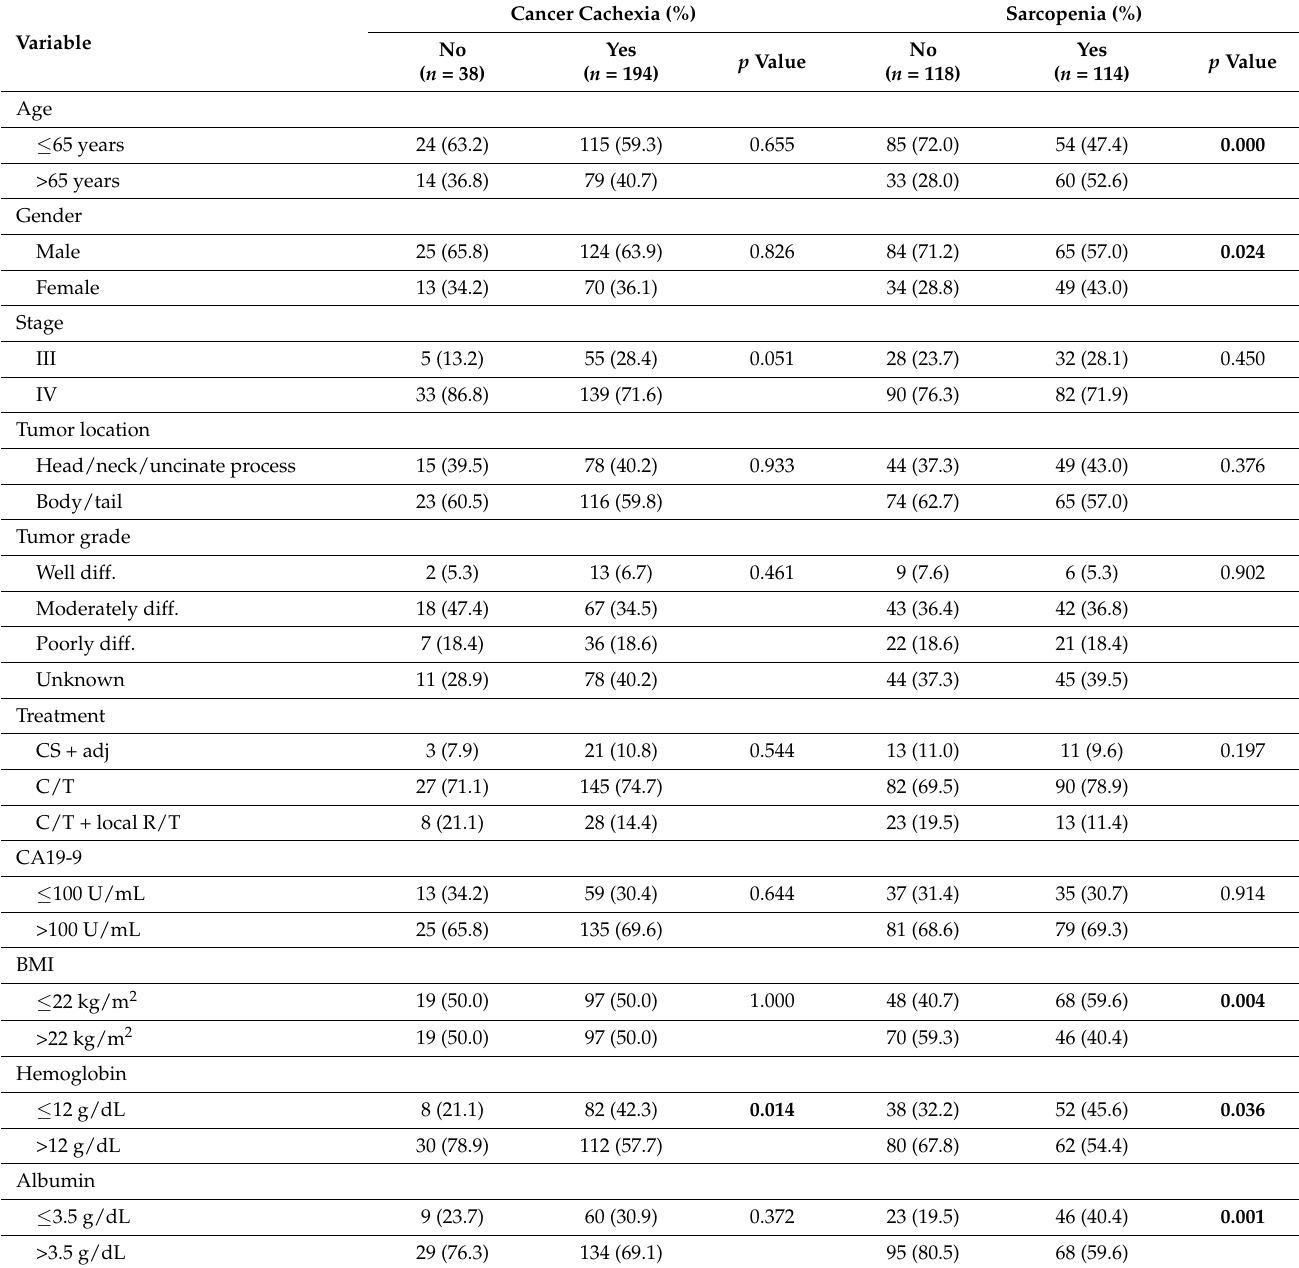
Table 2. Comparison of patient characteristics based on cancer cachexia and